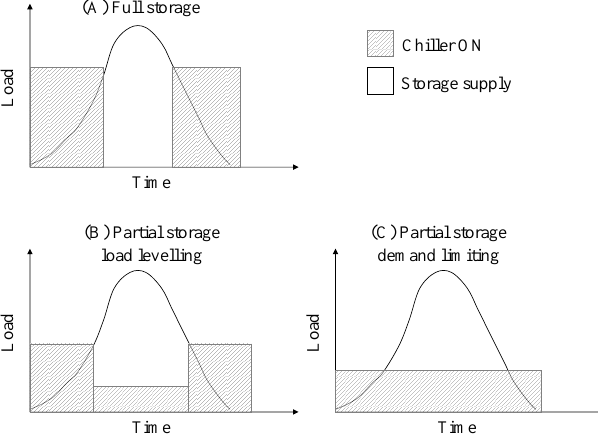
Figure 1. Cold thermal energy storage (CTES) operational strategies [29,30]. ( A ) A full storage strategy shifts the entire peak cooling load to off-peak hours. In a partial storage strategy, the load is partially supplied by the thermal storage and partially by the refrigeration unit. The chiller can be designed to operate as ( B ) load levelling or ( C ) demand limiting.